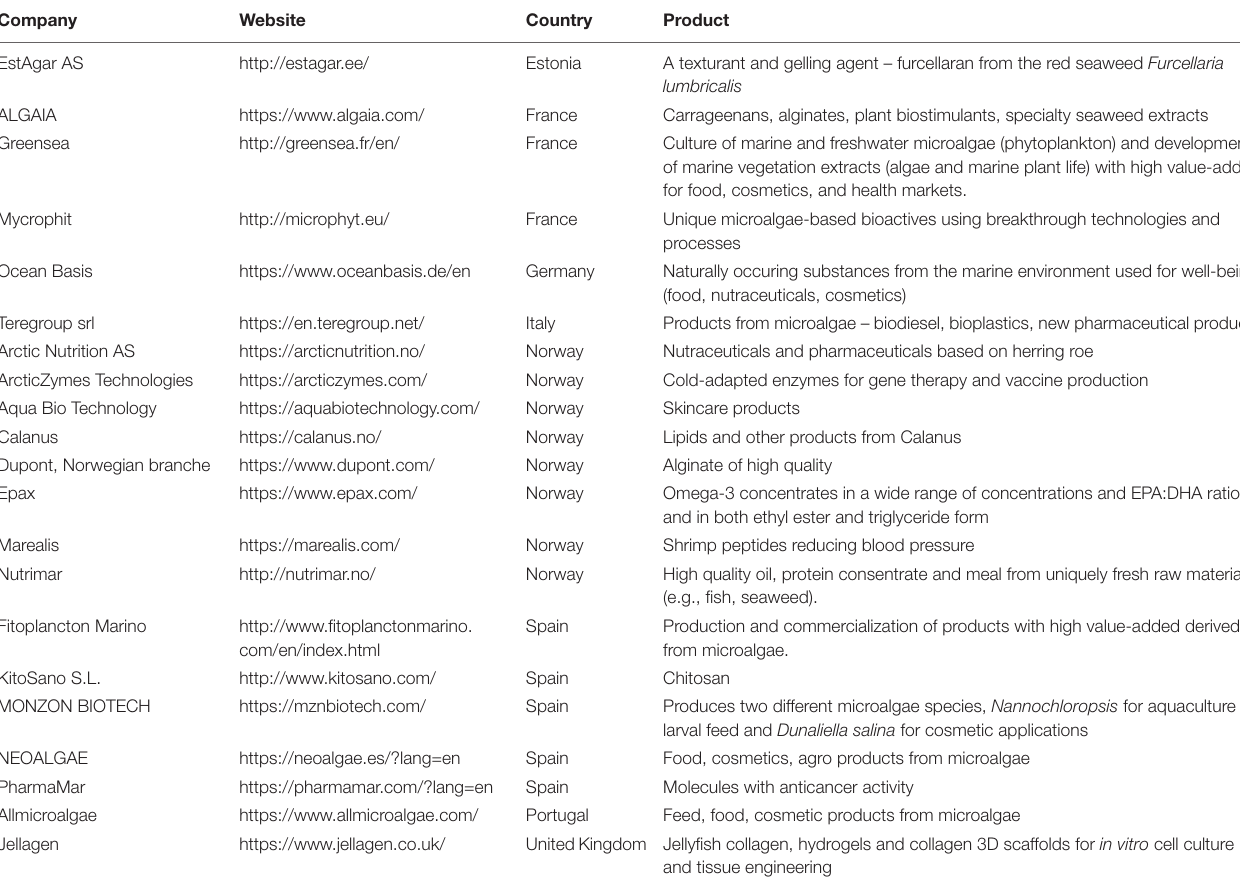
TABLE 3 | A non-exhaustive overview of the European companies offering marine biotechnology products.